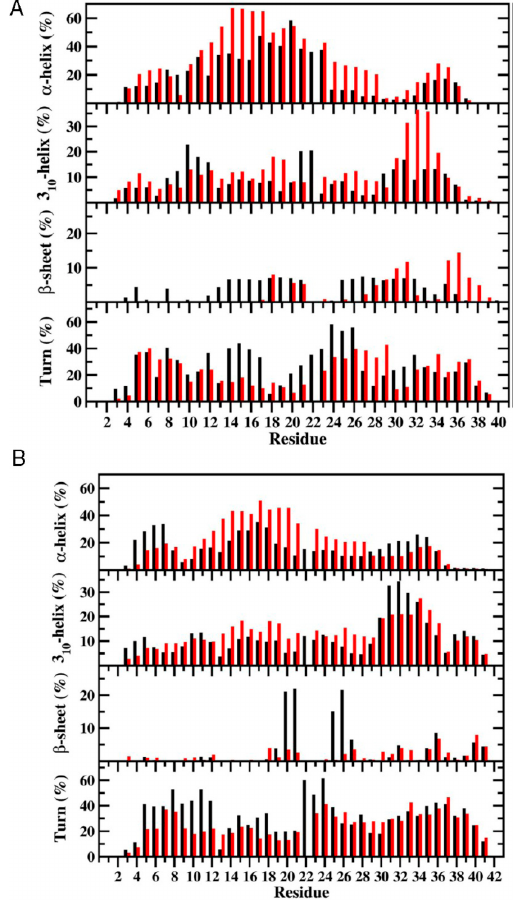
Figure 8. Calculated secondary structure abundances per residue for the ( A ) WT (black) and E22 Δ mutant (red) A β 40 and ( B ) WT (black) and E22 Δ mutant (red) A β 42 peptides in aqueous solution. The abundances for the π -helix and coil structures are not displayed.